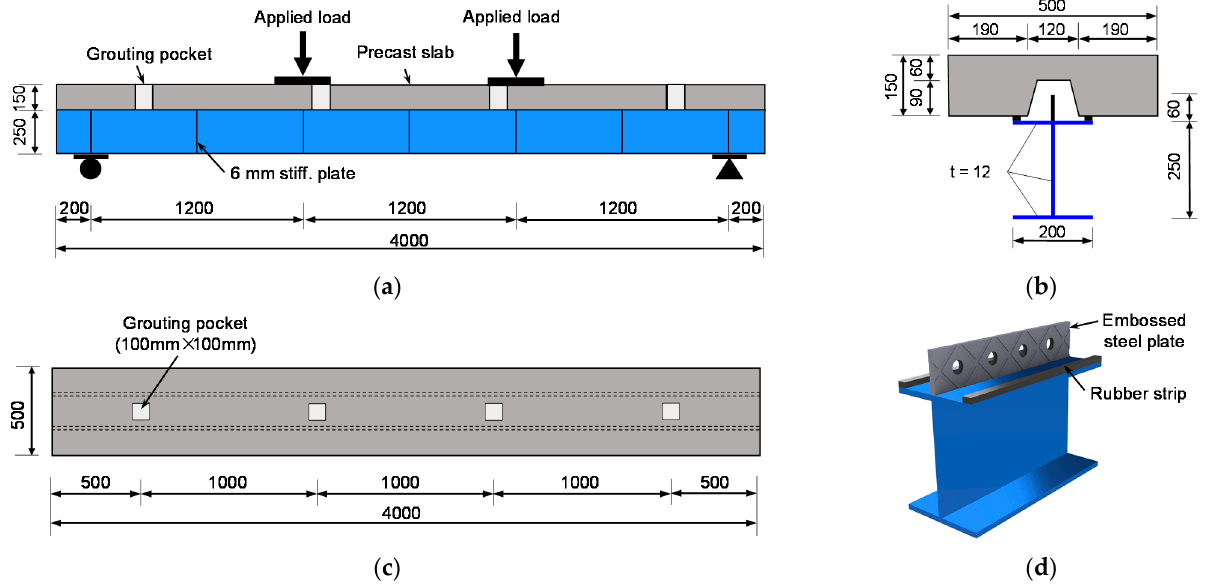
Figure 4. General details of composite beam specimens (dimensions in mm): ( a ) elevation view; ( b ) cross section ( c ) plane view; ( d ) beam segment.